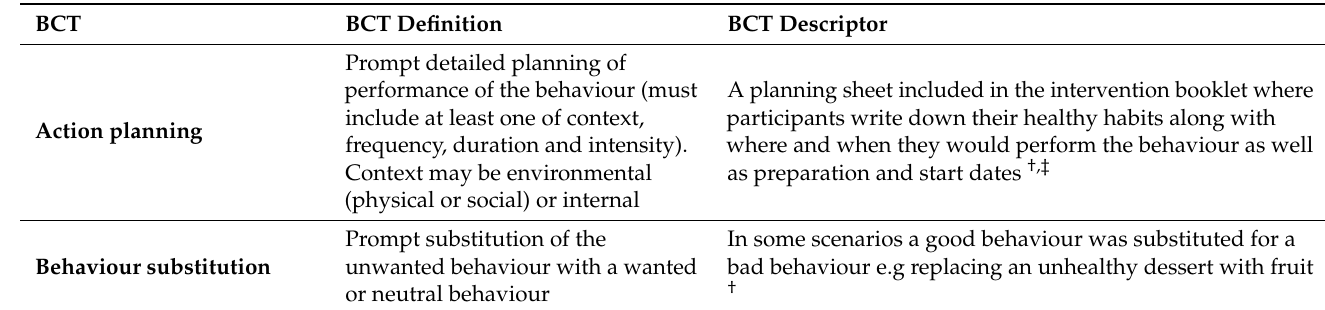
Table 2. BCTs for Intervention Group only using the 93 Item V1